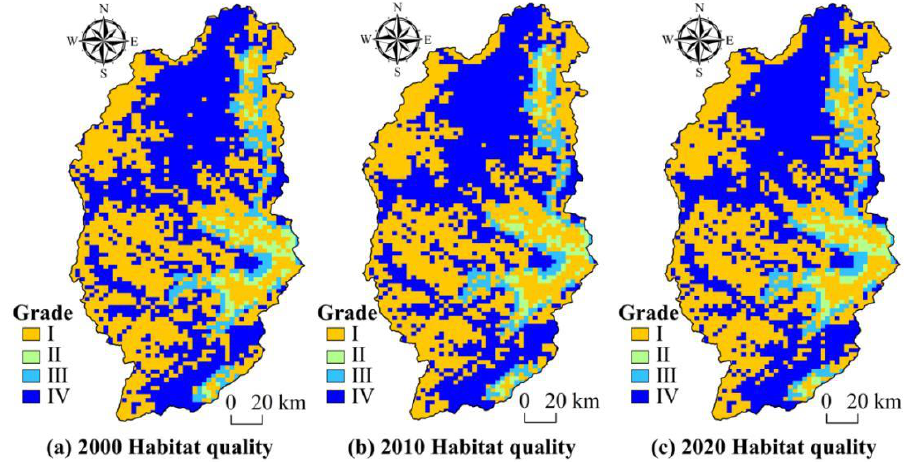
Figure 6. Distribution of habitat quality from 2000 to 2020: ( a ) 2000 ( b ) 2010 ( c ) 2020. From the perspective of temporal and spatial changes, the area of watershed Level IV decreased by 2% from 2000 to 2010, mainly changing from Level IV to Level III. The areas of habitat quality of Level II and Level I increased by 12.15% and 19.52%, respec- tively. From 2010 to 2020, the ecological quality area of Level IV decreased by 0.02%, Level III increased by 0.79%, and Level II decreased by 3.8%. The ecological quality area of Level I increased by 31.8%. Level II, Level III, and Level IV exhibited increases of 50.76%, 29.27%, and 20.92%, respectively. Overall, the habitat quality decreased from 2000 to 2020, which was reflected in the decrease in the area of Level IV habitat quality and the increase in the area of Level I habitat quality. By comparing the three years, we observed that the habitat quality of Level IV significantly decreased but the area of habitat quality of Level I con- tinues to increase (Figure 7), and the environmental pressures are still considerable.